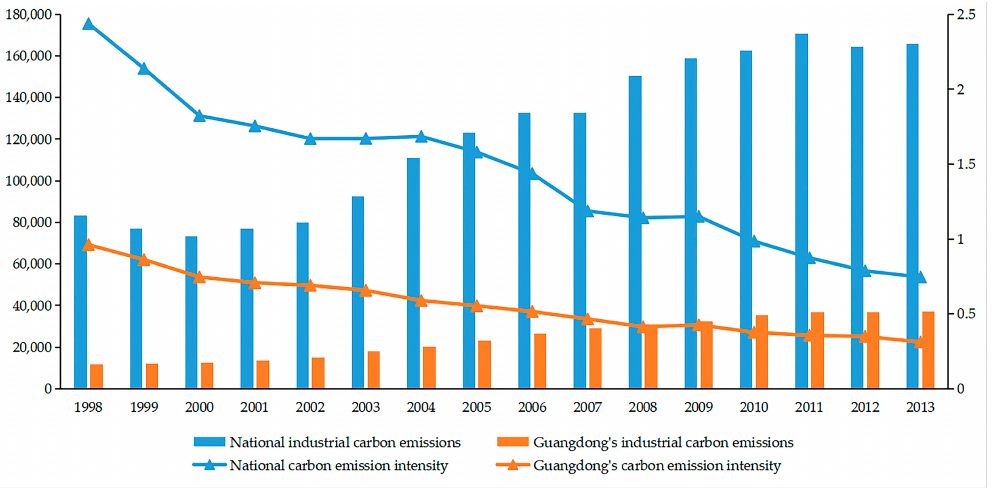
Figure 4. Comparison of Total Industrial Carbon Emissions and Carbon Emission Intensity between Guangdong Province and China from 1998 to 2013.